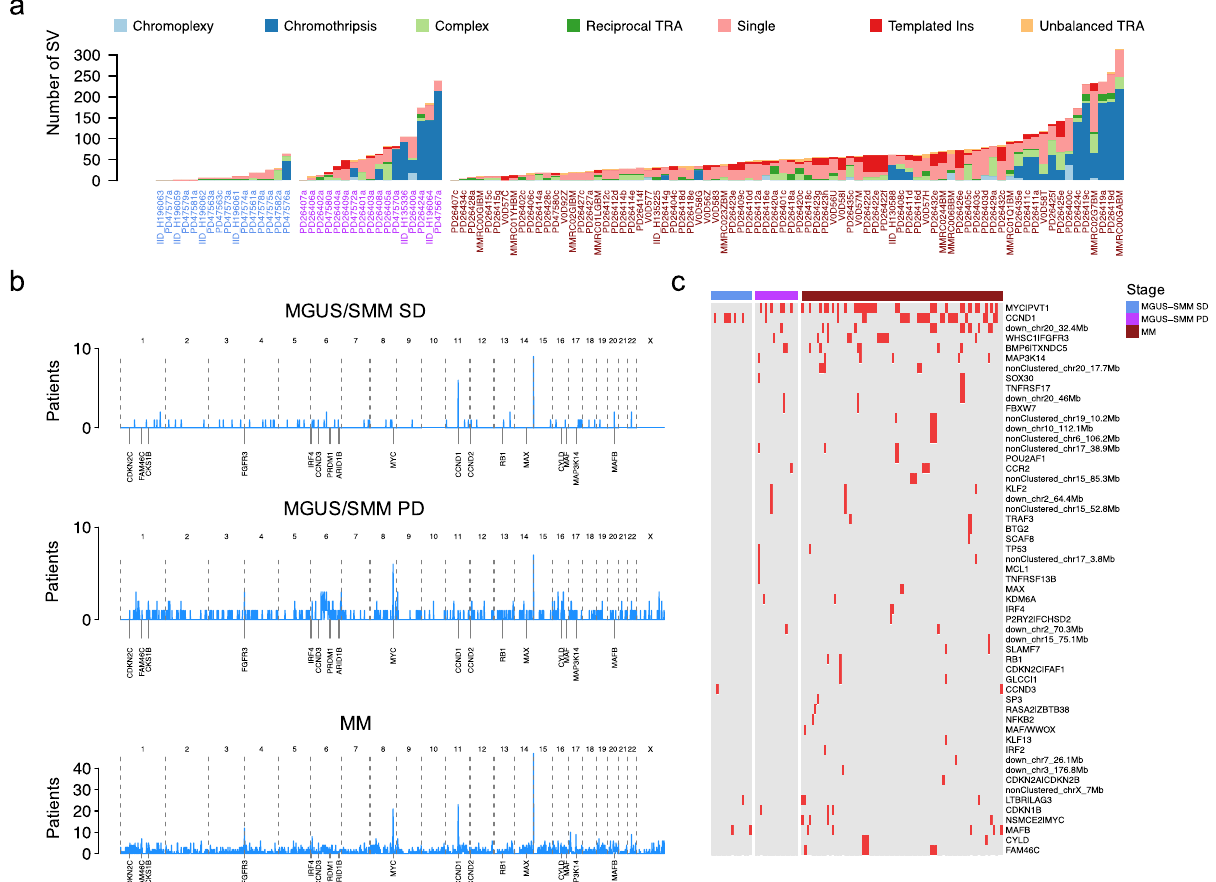
Fig. 5 Landscape of structural variants (SV) in multiple myeloma (MM) and myeloma precursor condition. a Prevalence of single and complex SV events across all cases included in this study. PD47563 is a patient with stable myeloma precursor condition with two samples collected at different time points, both reported in this plot (i.e., PD47563a and PD47563c). Blue, purple, and brown x -axis labels represent stable, progressive myeloma precursors and MM respectively. Ins: insertion, TRA: translocation. b Genome-wide density of SV breakpoints across stable, progressive myeloma precursors, and MM. Each patient genome was divided in bins of 1 Mb and, in case of presence of multiple SV breakpoints, only one breakpoint was counted. c Prevalence of 69 known SV hotspots across stable and progressive myeloma precursors, and MM. MGUS: monoclonal gammopathy of undetermined signi fi